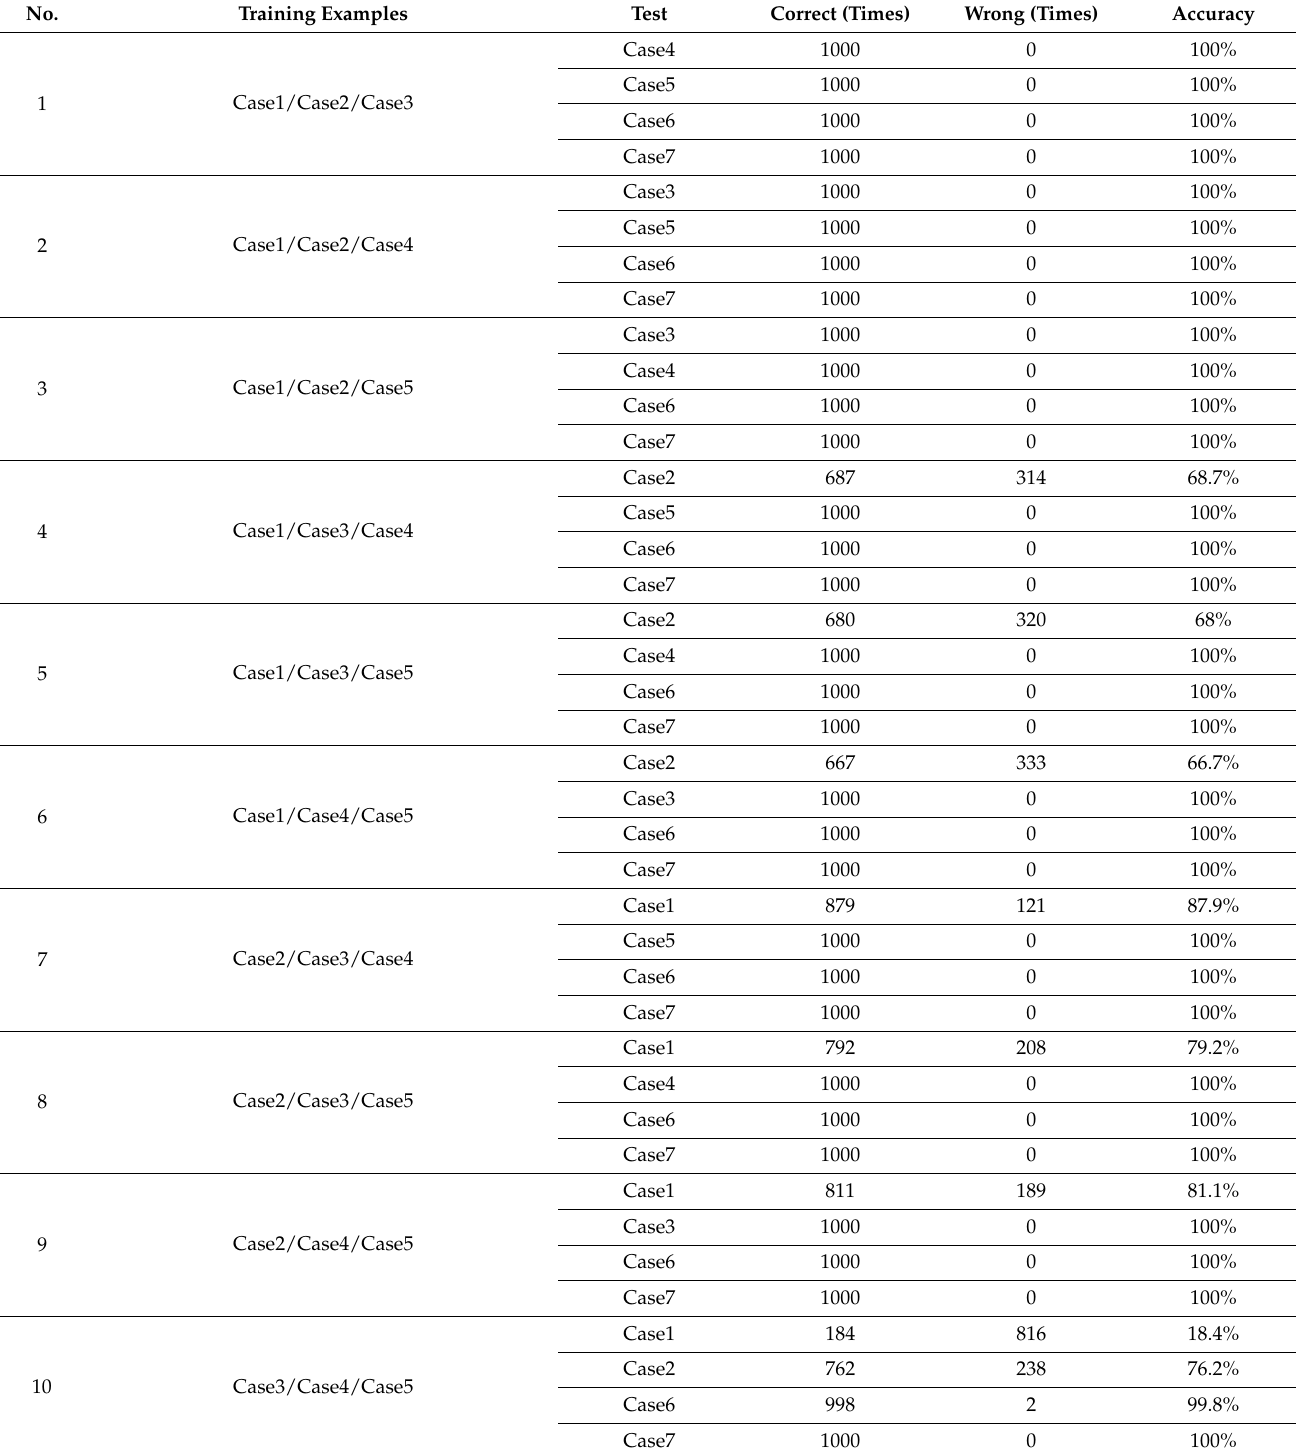
Table 4. The combination of three groups of health